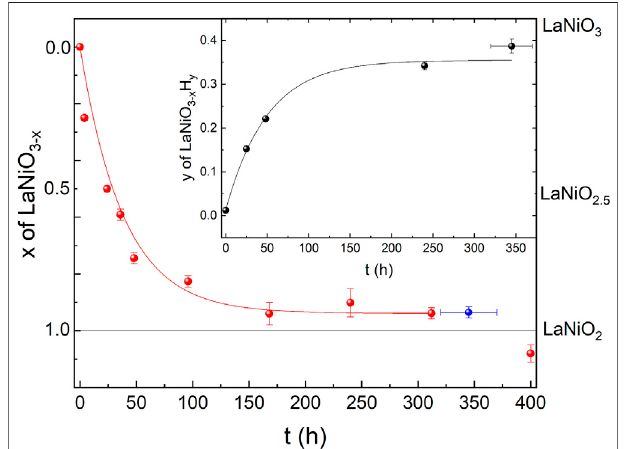
FIGURE 3 | Neutron powder diffraction. The data are taken from mixed samples reduced in the range of 320 – 376 h. The Rietveld re fi nement includes theLaNiO 2 phaseand aNiminority phase. Datawerecollectedat1.5 Kwitha neutron wavelength of 1.15 Å.